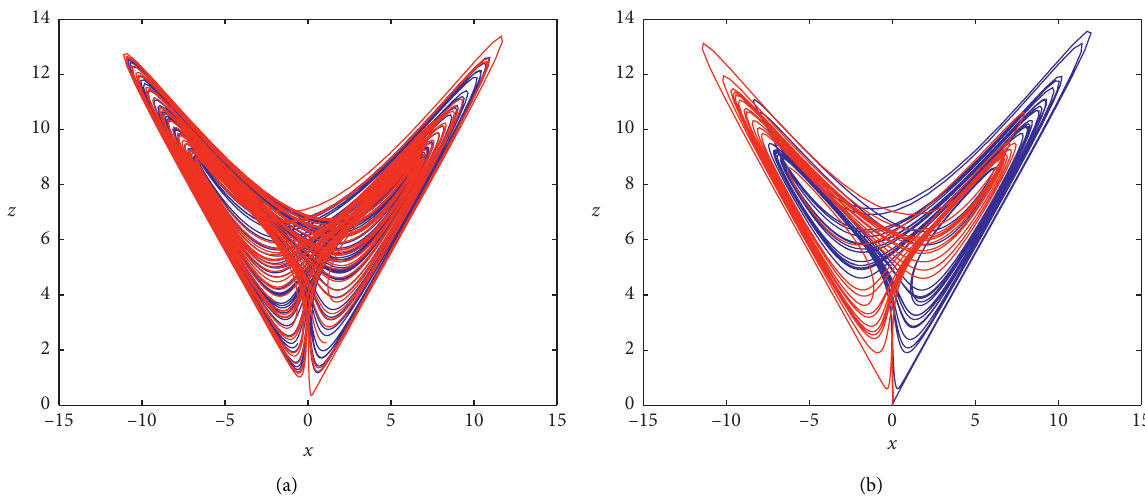
Figure 7: Phase diagrams in different projections of chaotic systems from initial values (1, 2, 20) and (1, 2, 3). (a) Phase diagrams in integer- order system (2). (b) Phase diagrams in fractional-order system (5).